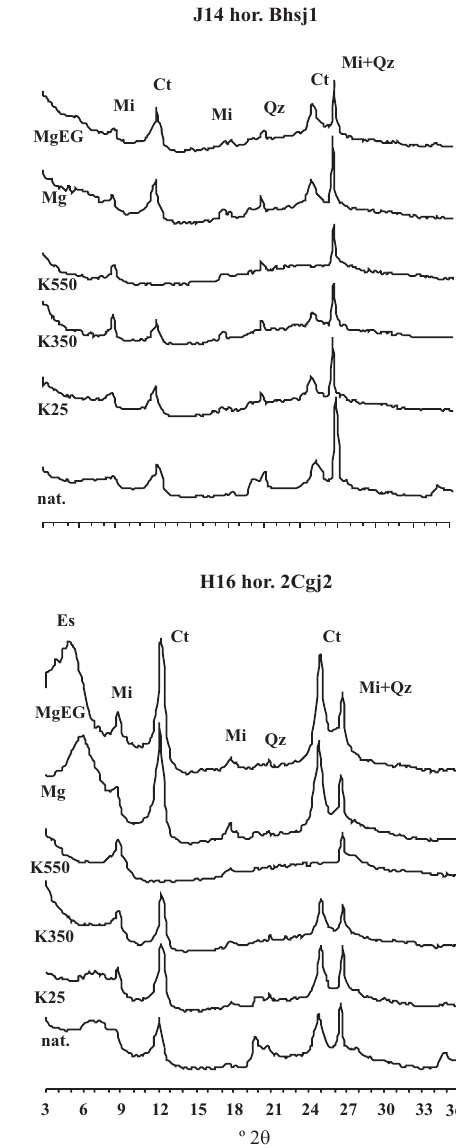
Figura 4. Difratogramas da fração argila do horizonte Bhs1 do perfil H9, horizonte Bhsj1 do perfil J14 e dos horizontes Bhsj3 e 2Cgj2 do perfil H16. Ct: caulinita, Mi: mica, Qz: quartzo, Gb: gibbsita, Es: esmectita, Ve: